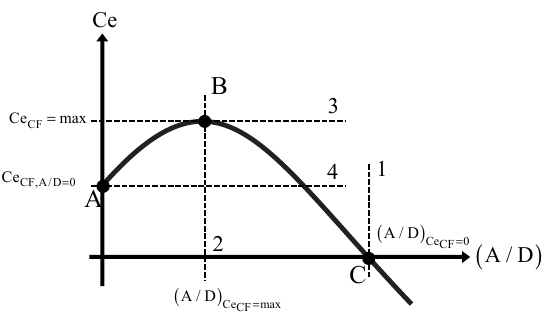
Figure 1. Three-point excitation coefficient curve for CF response.